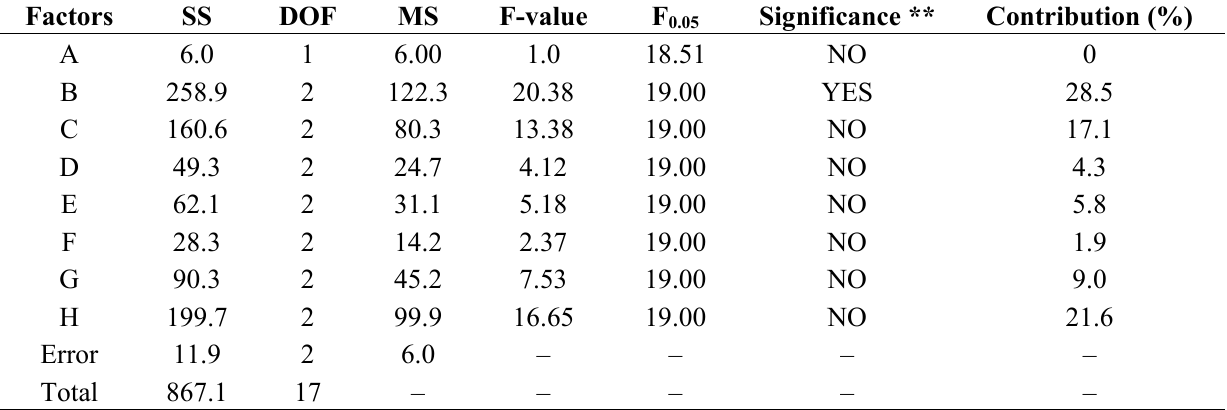
Table 6. Result of 2D offset distance in the condition of optimum level